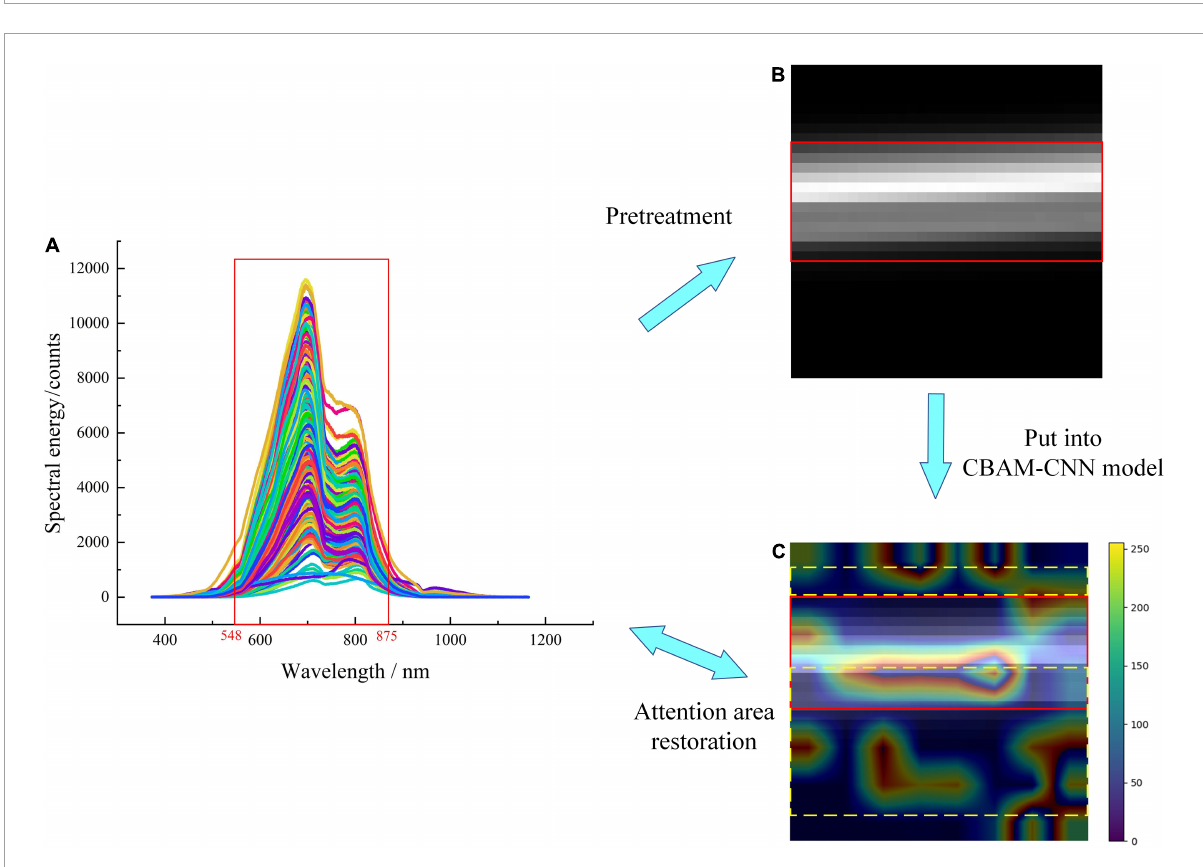
FIGURE12 Visualization of Grad-CAM attention area: (A) Original spectra, (B) original spectral matrix image, (C) attention area spectral image.